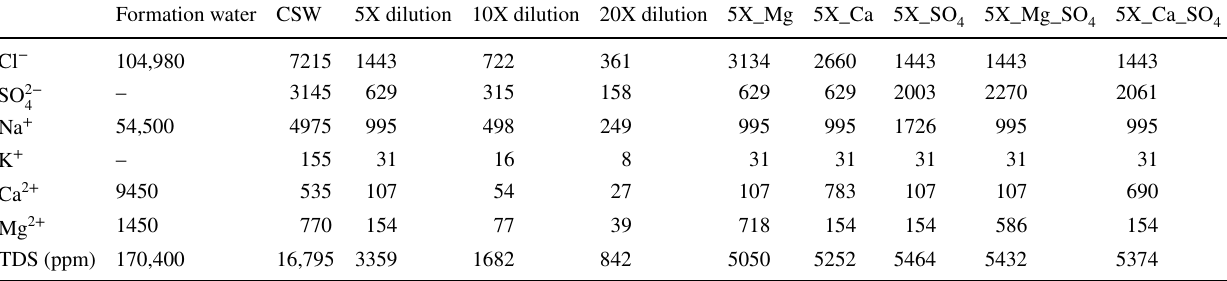
Table 3 Composition of LSW and ion-engineered brine samples Formation water